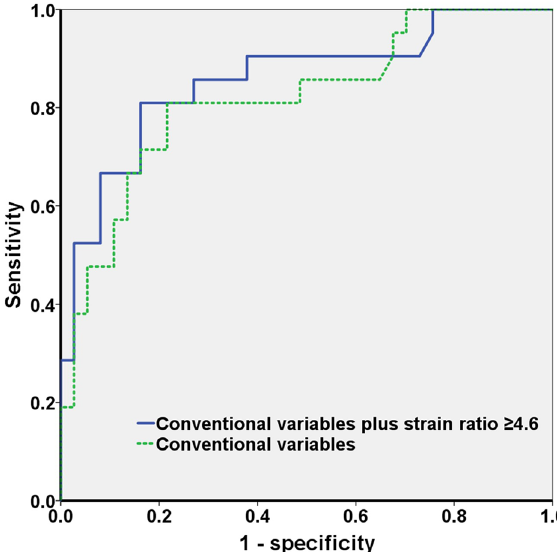
Figure 2. ROC curves of detecting prostate cancer lesion using clinical variables and the elastography strain ratio in PI-RADS score 3 lesions. PI-RADS, Prostate Imaging Reporting and Data System; ROC, receiver operator